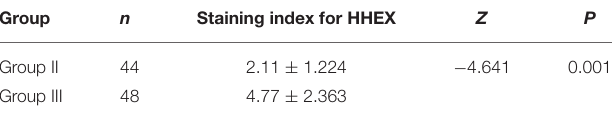
TABLE 2C | The difference of HHEX staining index between 44 cases of primary BC (group II) and 48 cases of benign breast tumors (group III).